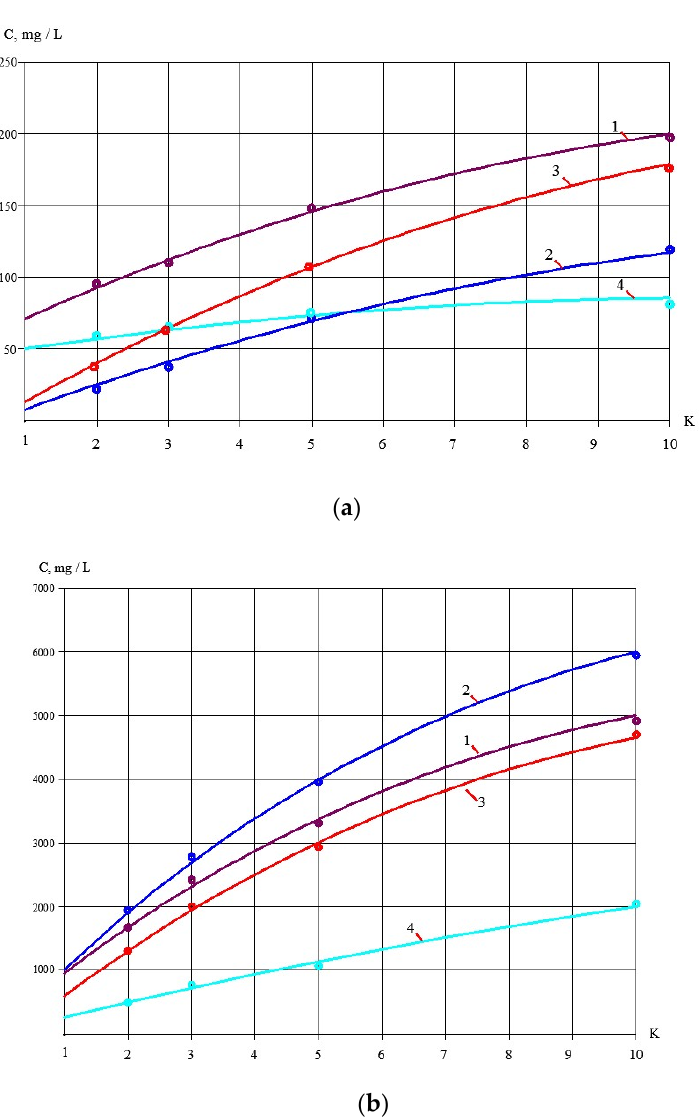
Figure 13. Treatment of the nanofiltration membrane product water by the second ‐ stage reverse osmosis membrane to produce a quality drinking water (Figure 2b) from the reject effluent: ( a ) dependencies of different ion and COD concentration values on K in concentrate; ( b ) dependencies of different ion and COD concentration values on K in permeate: 1—chlorides; 2—sulphates; 3—COD; 4—aluminum.